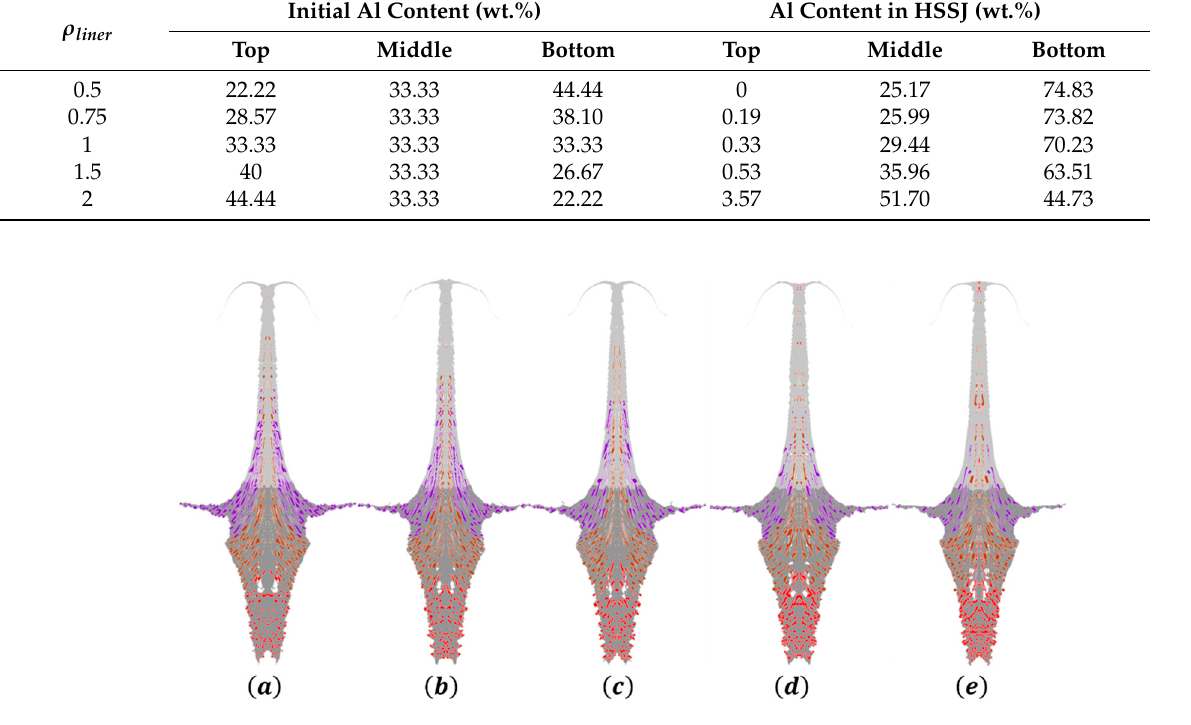
Figure 18. Typical images of 2 CD-standoff jet with different initial particle distribution: ( a ) 𝜌 (cid:3039)(cid:3036)(cid:3041)(cid:3032)(cid:3045) = 0.5 , ( b ) 𝜌 (cid:3039)(cid:3036)(cid:3041)(cid:3032)(cid:3045) = 0.75 , ( c ) 𝜌 (cid:3039)(cid:3036)(cid:3041)(cid:3032)(cid:3045) = 1 , ( d ) 𝜌 (cid:3039)(cid:3036)(cid:3041)(cid:3032)(cid:3045) = 1.5 and ( e ) 𝜌 (cid:3039)(cid:3036)(cid:3041)(cid:3032)(cid:3045) = 2 . Note : The particle colors are the same as in Figure 15. The light gray corresponds to HSSJ while the dark gray corresponds to slug.